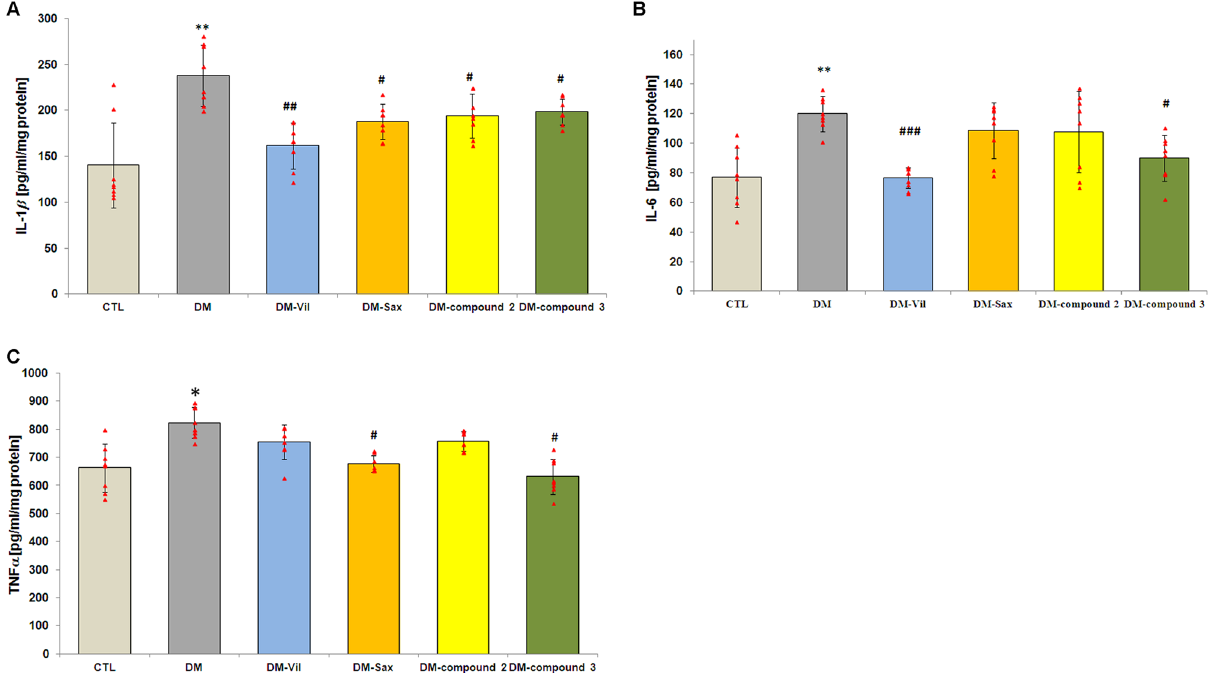
Figure 7. Anti-inflammatory effects of novel adamantane derivatives (2,3), and drugs- vildagliptin and saxagliptin in brain of diabetic mice. Comparison of IL-1β ( A ), IL-6 ( B ), and tumor necrosis factor-α (TNFα) ( C ) among the experimental groups. Bars in figure illustrate experimental groups— CTL non-diabetic mice, DM diabetic mice, DM‑Vil vildagliptin treated mice [20 mg/kg, po ], DM‑Sax saxagliptin-treated mice [10 mg/ kg, po ], DM‑compound 2 compound 2-treated mice [50 mg/kg, po ], DM‑compound 3 compound 3-treated mice [50 mg/kg, po ], respectively. Data is presented as mean ± SD (n = 8). One-way ANOVA, followed by Tukey’s post hoc test was used. p < 0.05, **p < 0.01 in comparison with control group; # p < 0.05 and ## p < 0.01, ### p < 0.001 in comparison with diabetes group.